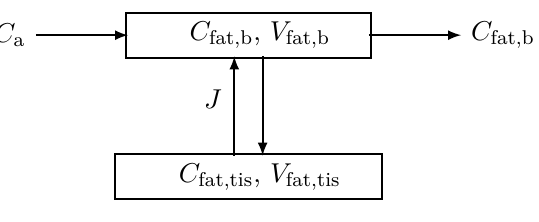
Figure A1. Model for the fat compartment with blood flow and tissue. Arterial blood with concentra- tion C a is entering and blood with concentration C fat,b is leaving the